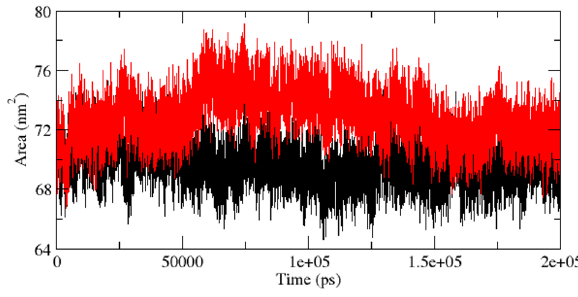
Figure 6. Radius of gyration of C a atoms of native and mutant Aurora-A protein versus time at 300 K. Native is shown in black and mutant in red.